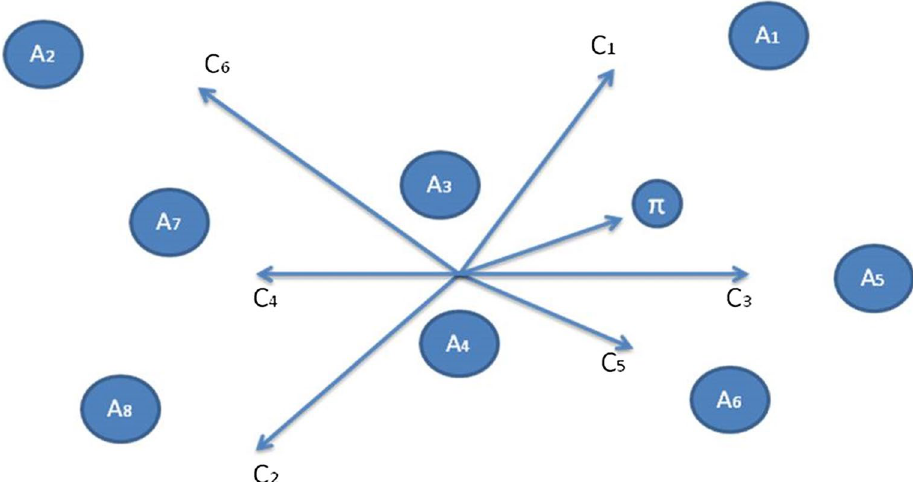
Fig. 2 Alternatives and criteria in the GAIA plane. (modified from Brans et al.